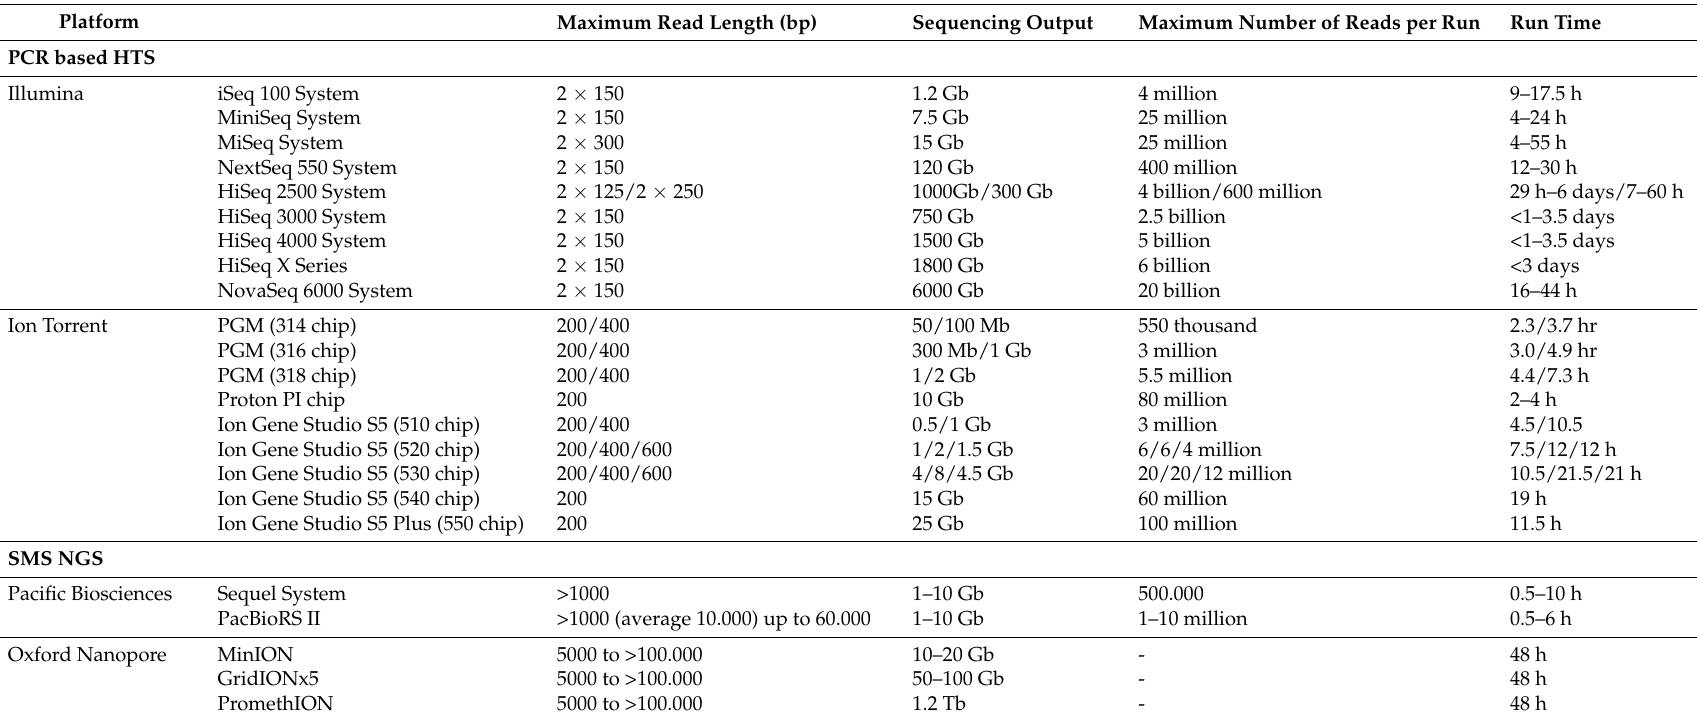
Table 1. Currently commercially available high-throughput sequencing